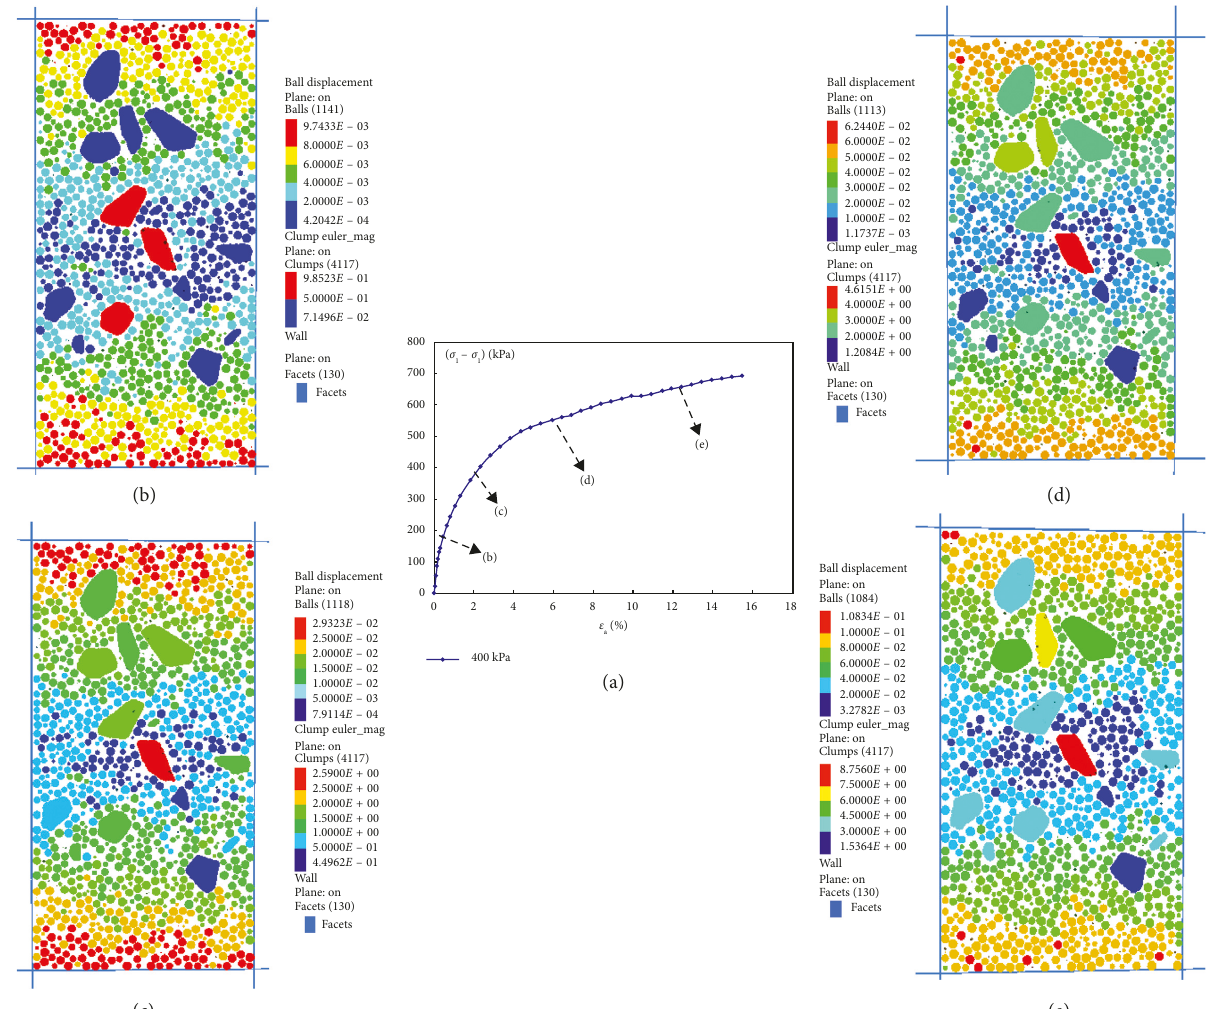
Figure 6: Particle position changes during compression: (a) stress-strain curve; (b) particle position at 1% strain; (c) particle position at 3% strain; (d) particle position at 6% strain; (e) particle position at 12%